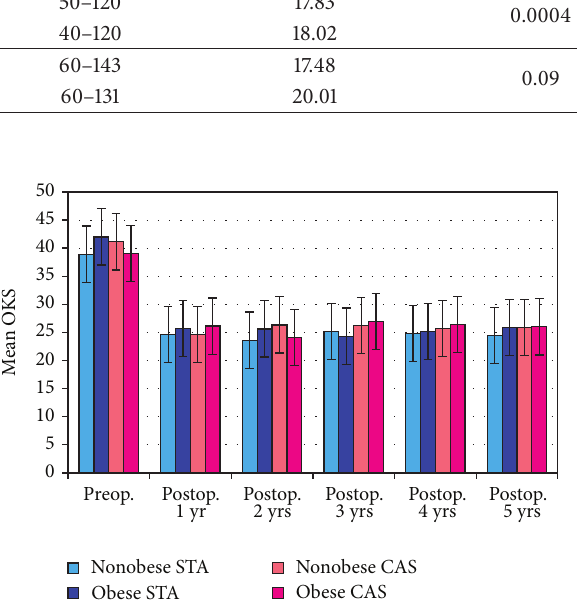
Figure 3: Mean OKS of the four groups of TKR over